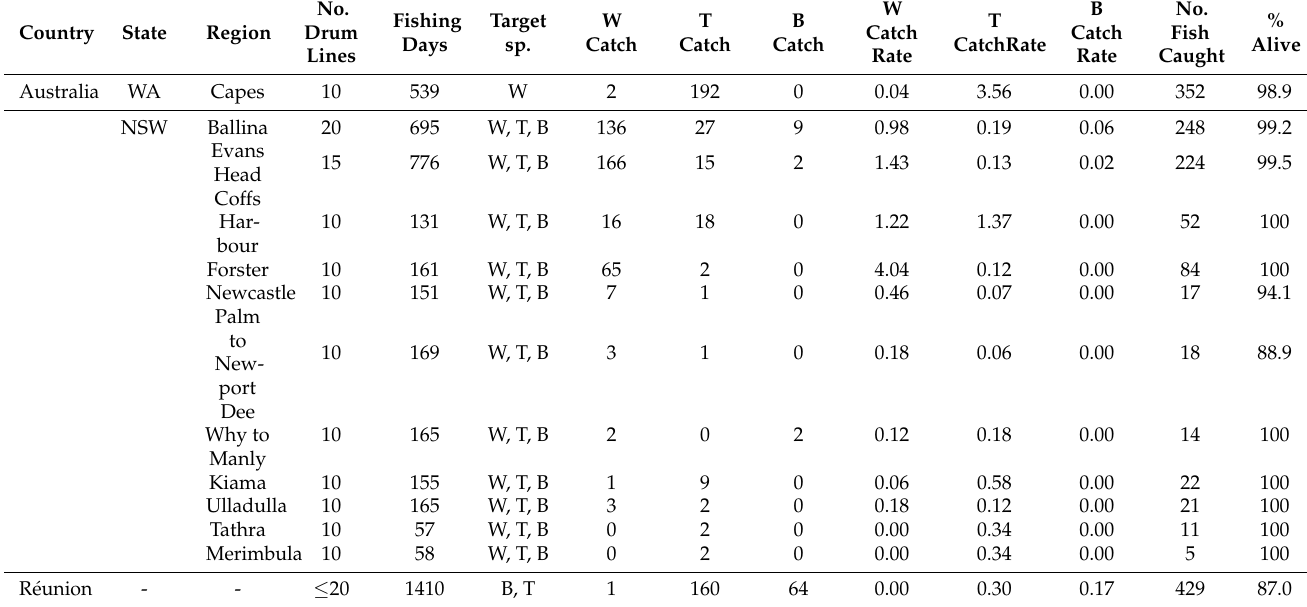
Table 2. Comparison of fishing gear, fishing days, target species and catch composition from SMART drumline programs. Data for NSW relates to results across all trials from 8 December 2016 to 1 December 2019, accessed on 1 December 2021 from https://www.sharksmart.nsw.gov.au/__data/ assets/pdf_file/0020/1237016/sms-factsheet-smart-drumlines.pdf. Data for R é union Island